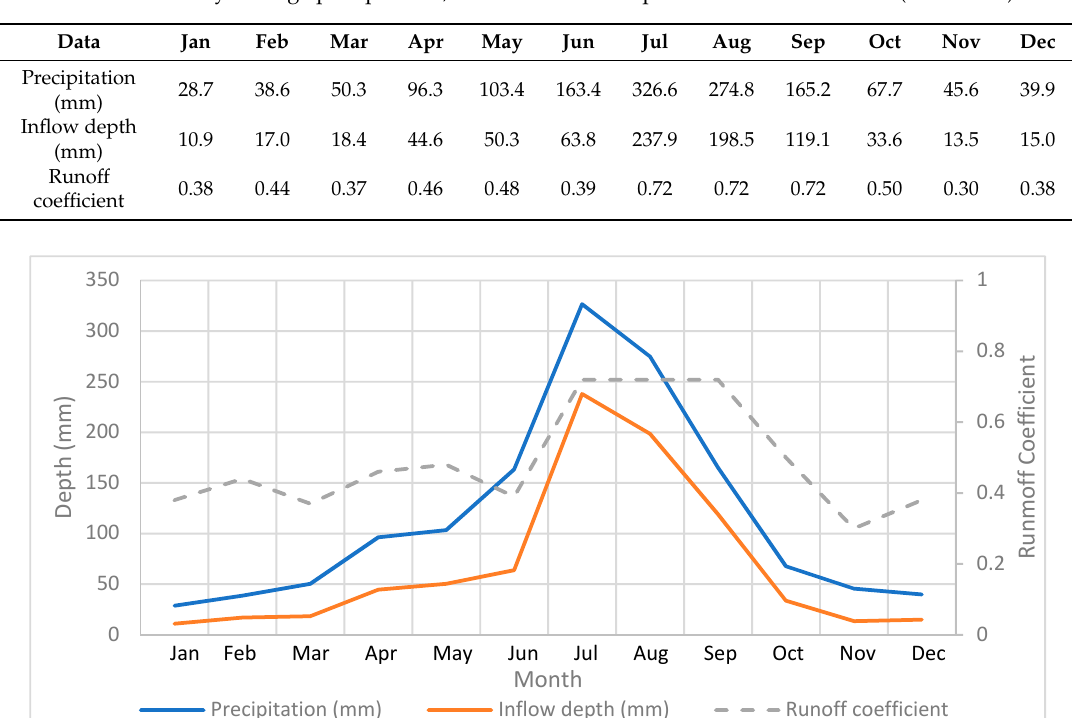
Table 1. Monthly average precipitation, reservoir inflow depth and runoff coefficient (1998–2016).